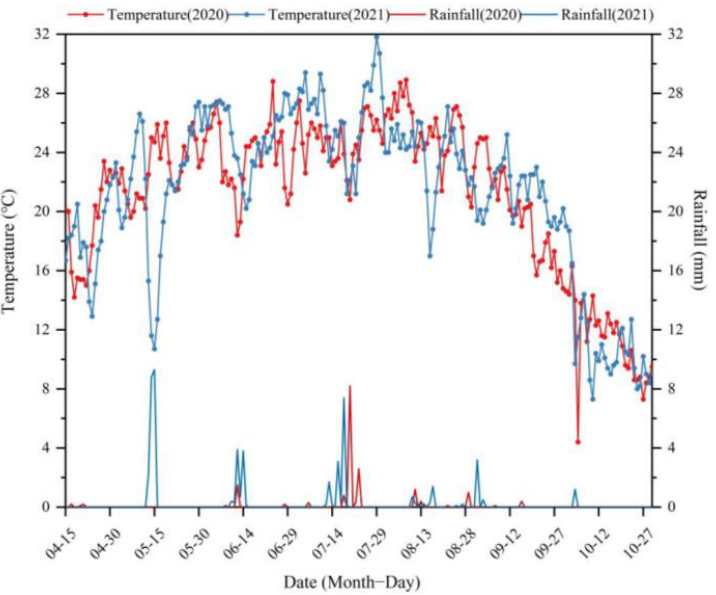
Figure 2. The rainfall and daily average temperature of the experimental field in 2020 and 2021.